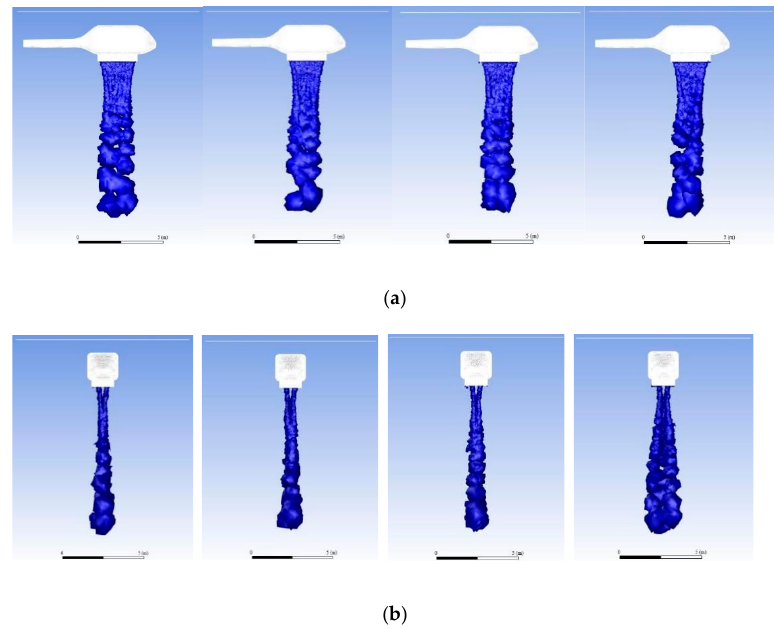
Figure 24. Contour surface of the two-phase, water–air interface at a volume fraction of 0.01 under different wind speeds ( H = 10 m; the ground is at the ruler in the figure; t = 1.2 s). ( a ) Side view, showing U = 0 m/s, 5 m/s, 10 m/s, and 15 m/s, respectively, from left to right. ( b ) Front view, displaying U = 0 m/s, 5 m/s, 10 m/s, and 15 m/s, respectively, from left to right.